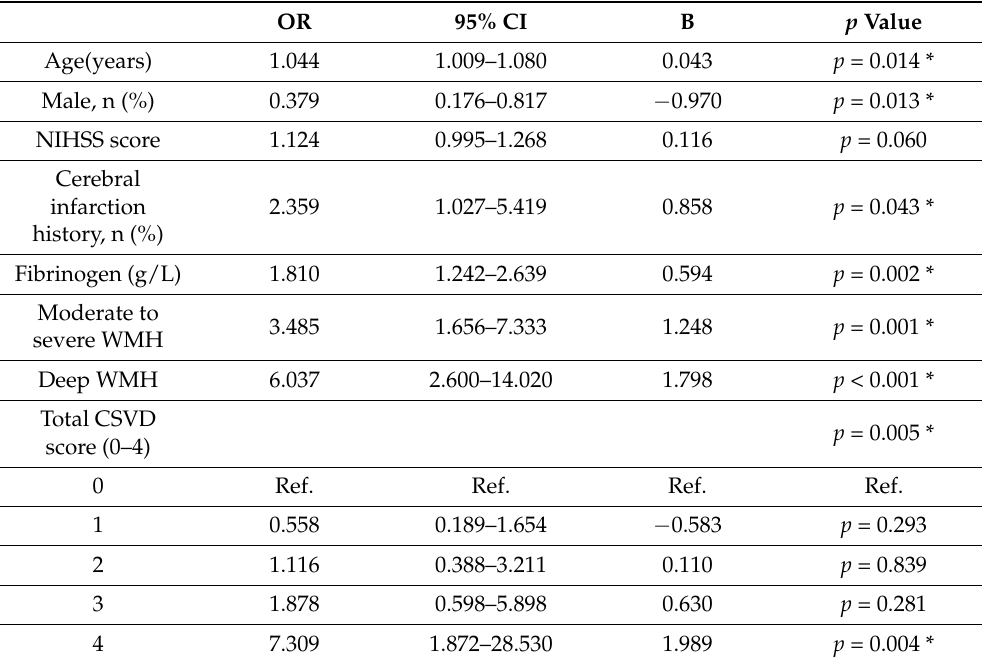
Table 2. Multivariable logistic regression analysis of risk factors associated with cognitive